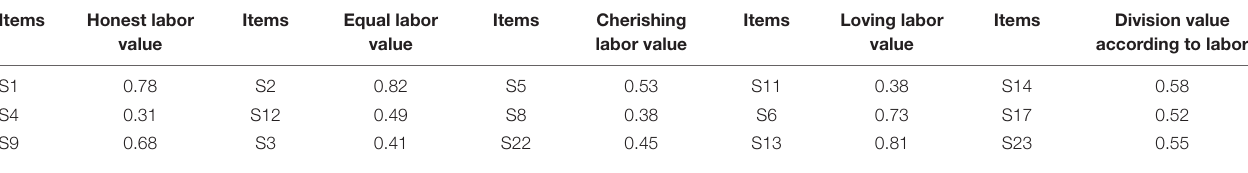
TABLE 2 | Factor normalized load estimation results basing on confirmatory factor